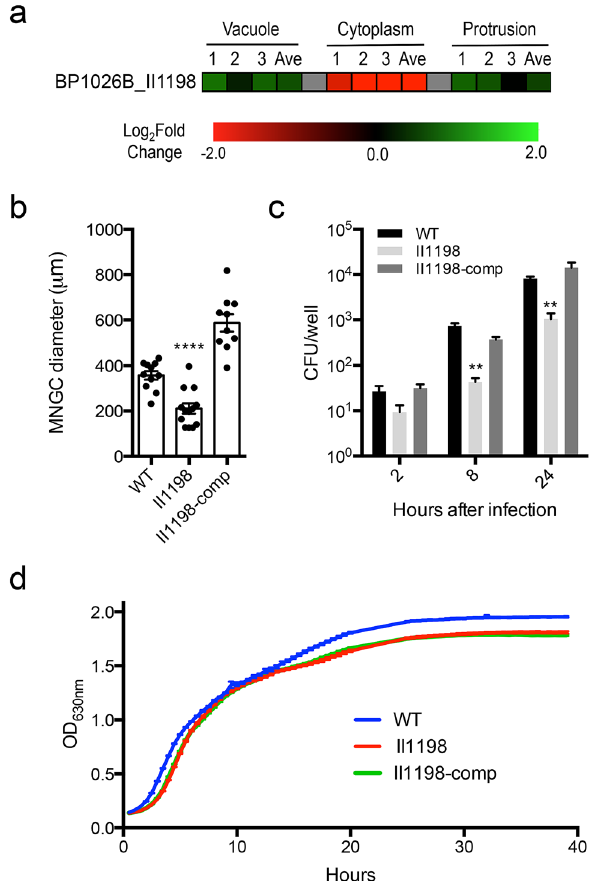
Figure 1. BP1026B_II1198 is differentially regulated during cell infection and critical for intracellular survival. ( a) Single cell ‘transitome’ analysis 7 shows that BP1026B_II1198 is up-regulated in the vacuole and protrusion while down-regulated in the cytoplasm during infection of RAW264.7 cells. Boxes represent three biological replicates and an average (Ave) 7 . ( b ) A mutant in BP1026B_II1198 shows a reduced ability to form wildtype level MNGCs. When the mutant is complemented it recovers beyond wildtype level of MNGC size. Individual MNGC diameters are shown as dots. ( c ) The BP1026B_II1198 mutant shows a significant reduction in intracellular replication at 8 and 24 h after infection compared to wildtype Bp 1026b. Complementation of the BP1026B_II1198 mutant recovers the intracellular replication to wildtype levels. ( d ) The BP1026B_II1198 mutant and complement grow to similar levels of wildtype Bp 1026b in vitro. Data in bar graphs and growth curve represent means ± s.e.m and analyzed via unpaired t-test. P values presented are as follows: ** p < 0.01, ****p <